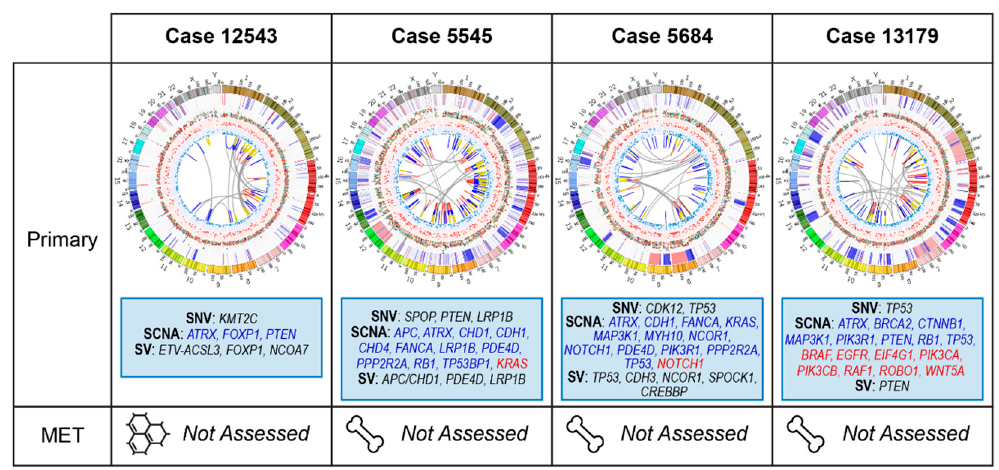
Figure 5. Summary of relevant genomic alterations for cases with subsequent metastatic relapse post radical prostatectomy (cases 12543, 5545, 5684, 13179); Circos plots as per Figure 3, with red text indicating SCNA loss.